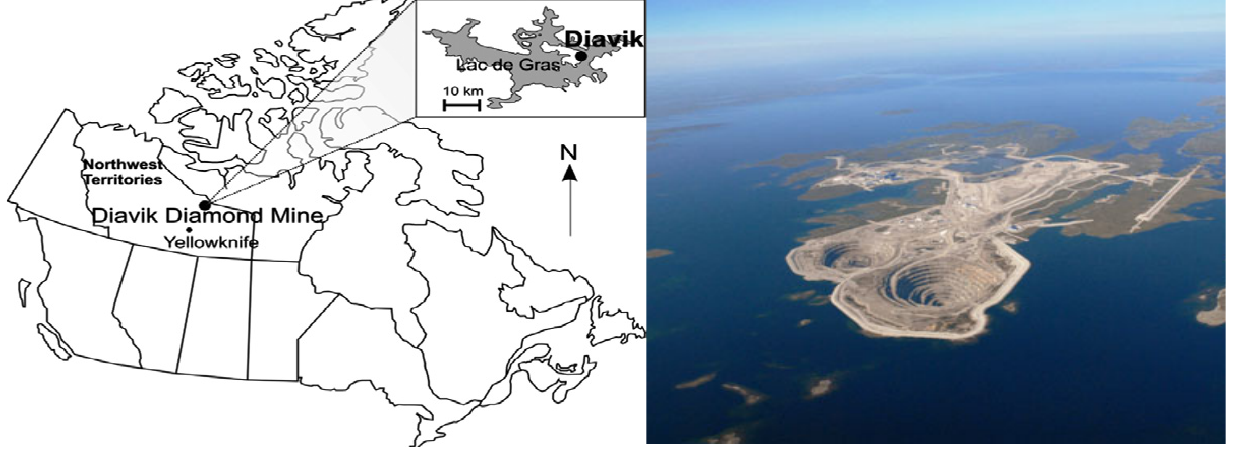
Figure 1. The Diavik Diamond Mine is located on East Island in Lac de Gras, 300 km northeast of Yellowknife, Northwest Territories, Canada, and 220 km south of the Arctic Circle (photo courtesy of Diavik Diamond Mines, Inc., Yellowknife, Northwest Territories (NWT),